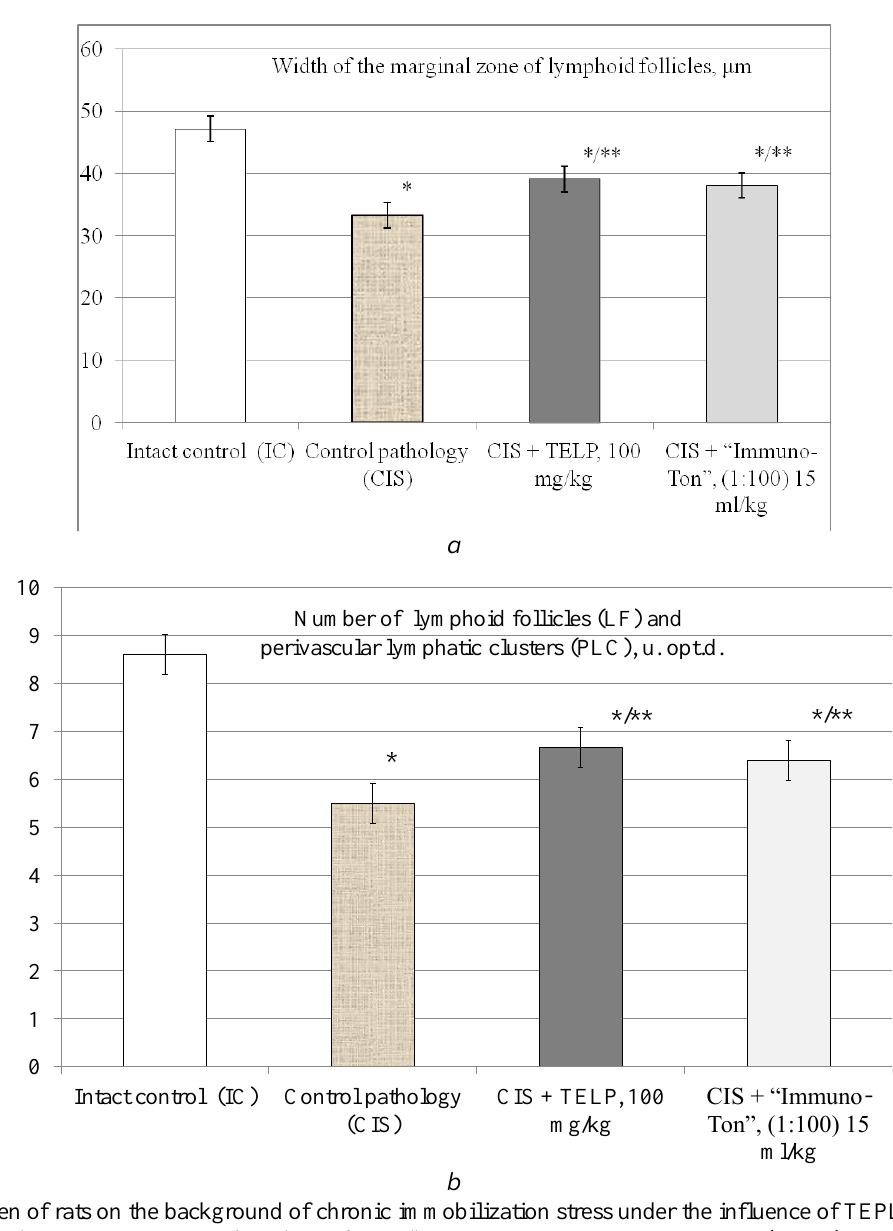
Fig. 3. Spleen of rats on the background of chronic immobilization stress under the influence of TEPL at a dose of 100 mg/kg and CD “Immuno-Ton” in a dose of 3 mg/kg: а – width of the marginal zone (WMZ); b – the number of lymphoid follicles (LF) and perivascular lymphatic clusters (PLC); * – statistical differences with respect to the indica- tors of animals in the group of infectious agents, p <0.05; ** – statistical differences with regard to the indicators of animals in the CP group, p